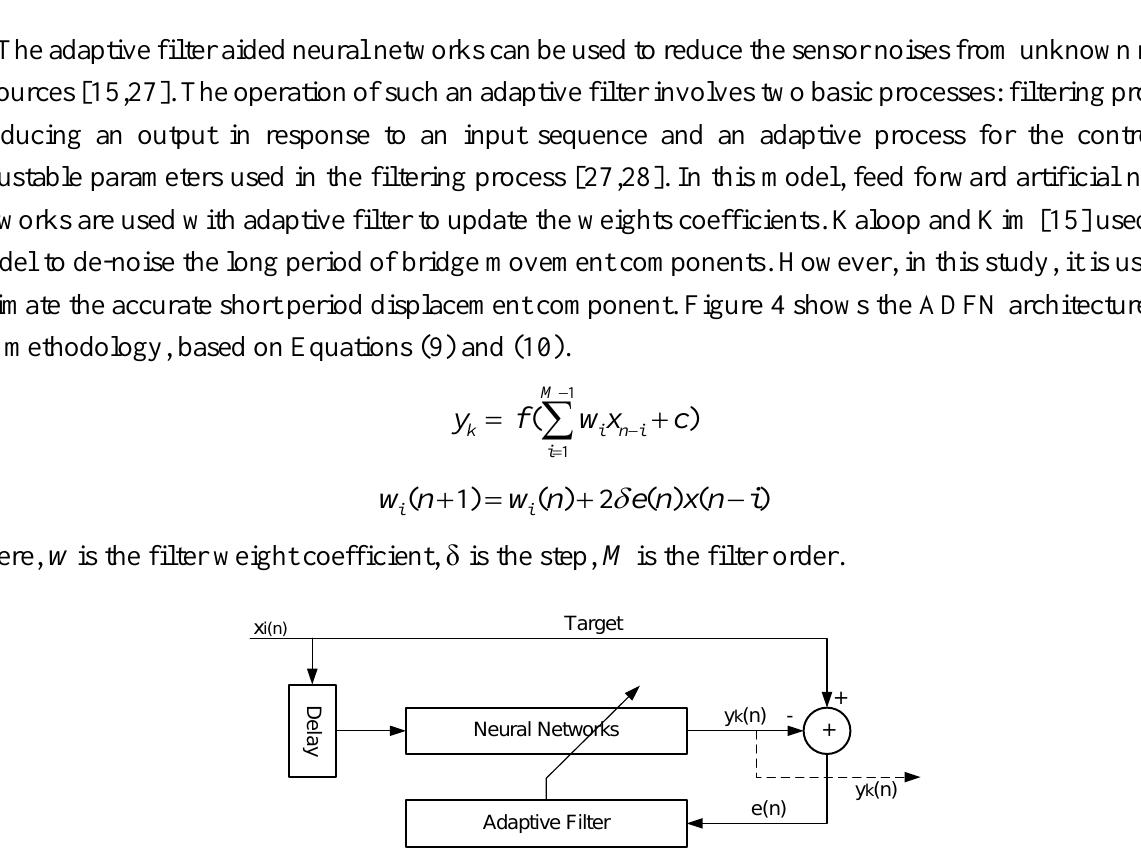
Figure 4. Adaptive filter neural networks